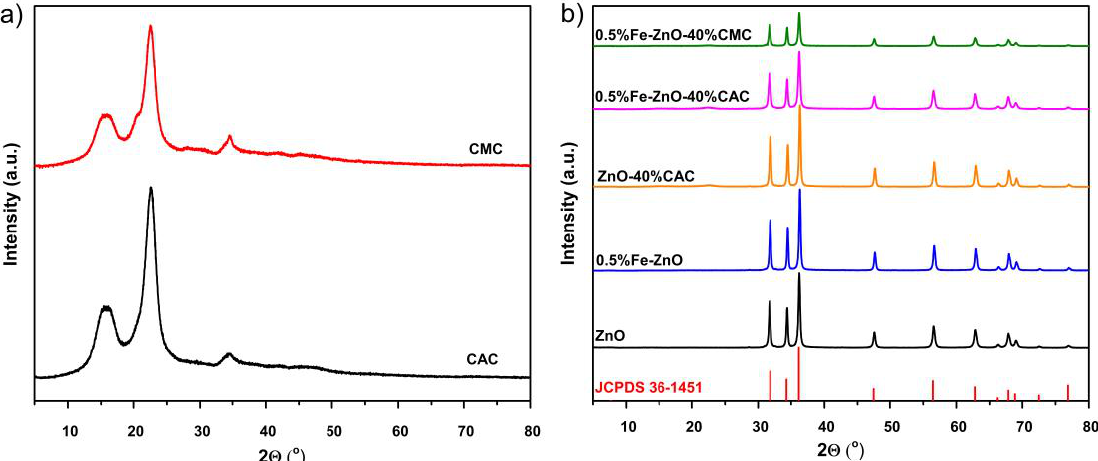
Figure 4. XRD patterns of the ( a ) purchased microcrystalline cellulose (CMC) and their citric acid modification (CAC); ( b ) ZnO-based composites with 0.5% Fe and/or 40% cellulose.